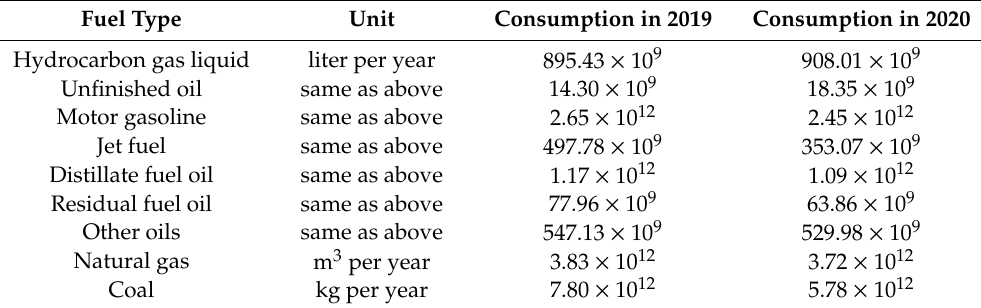
Table 1. Global fossil fuel consumption in 2019 and 2020